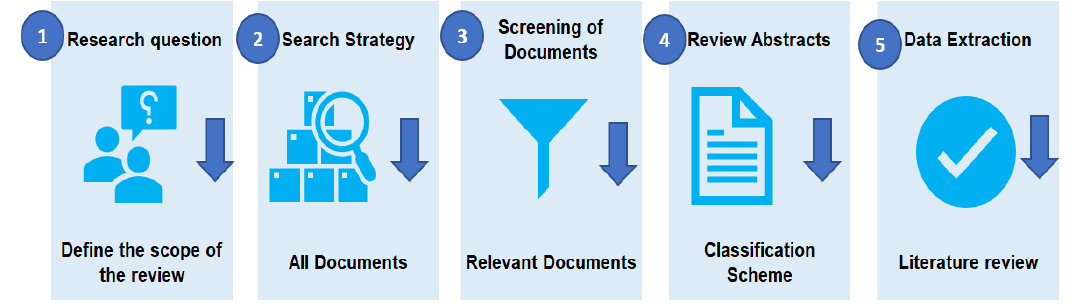
Figure 2. Review process.